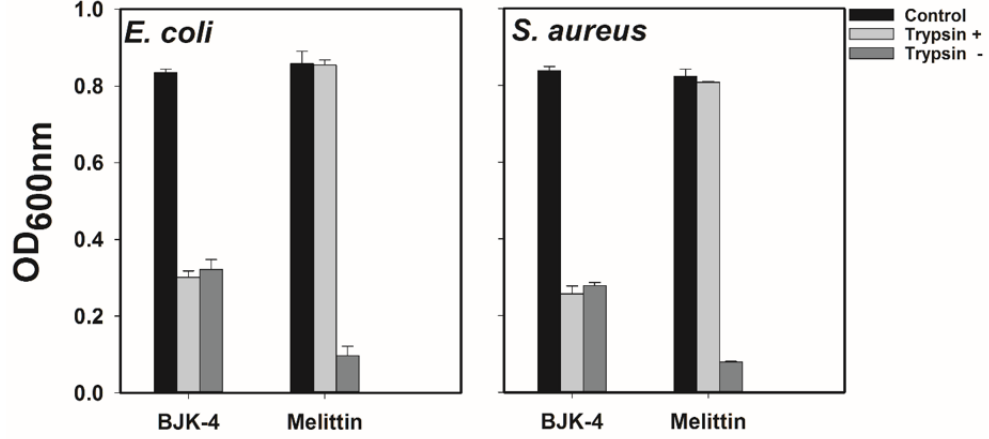
Figure 5. Effect of trypsin on the antimicrobial activity of BJK-4 and Melittin. E. coli KCTC 1682 and S. aureus KCTC 1621 strains were used. Control represents bacteria alone.